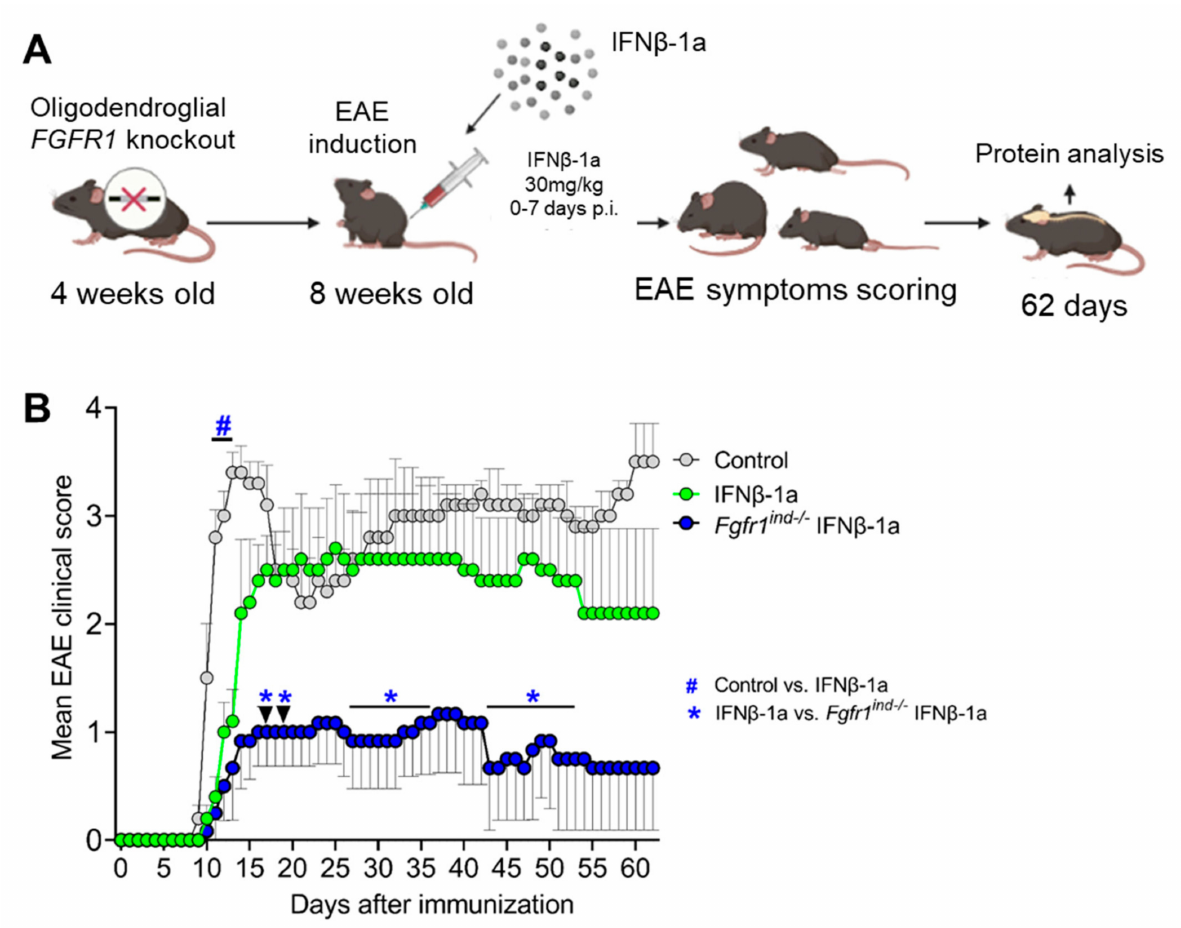
Figure 1. Experimental design and the clinical outcome of EAE scores. ( A ) Tamoxifen-induced FGFR1 knockout was created in 4-week-old mice, and at 8 weeks of age, control and Fgfr1 ind − / − mice were immunized subcutaneously with MOG 35-55 -peptide emulsified in CFA. Both mice